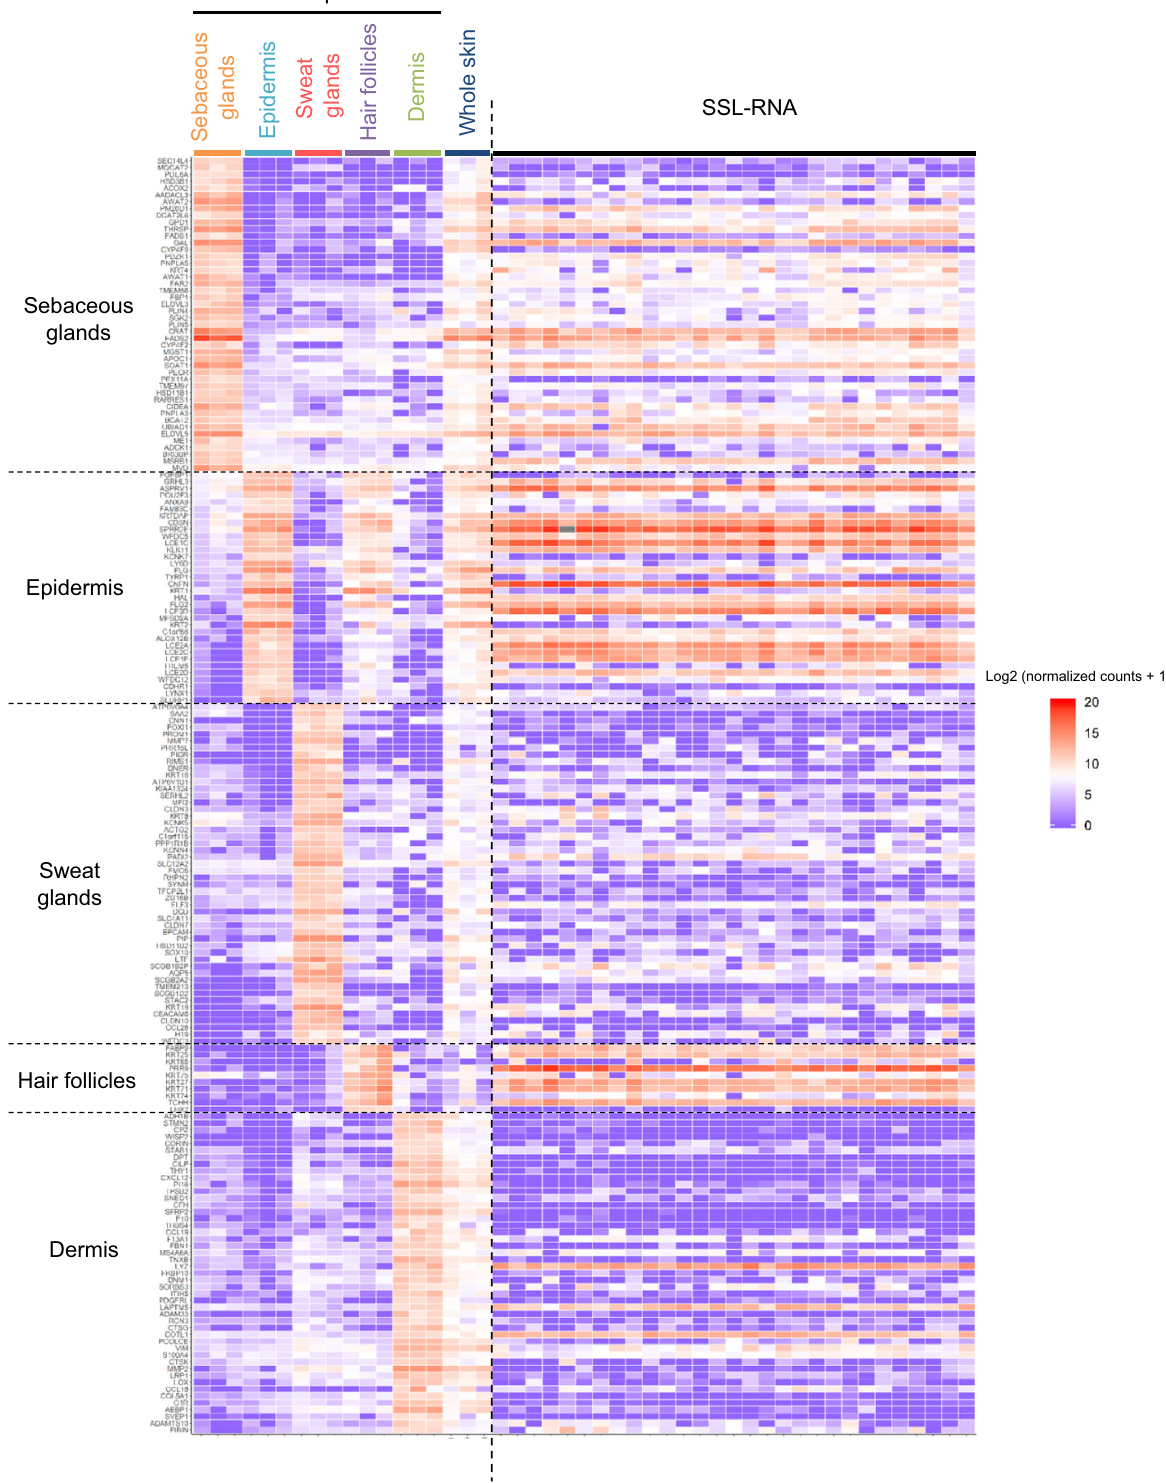
Fig. 4 mRNA expression characteristic of different skin regions and its comparison with the expression pro fi le of SSL-RNAs. Heatmap showing the expression pro fi les for each region (sebaceous glands, epidermis, sweat glands, hair follicles, and dermis) isolated using LMD, whole skin from three healthy male subjects, and SSL-RNAs obtained from 29 healthy male